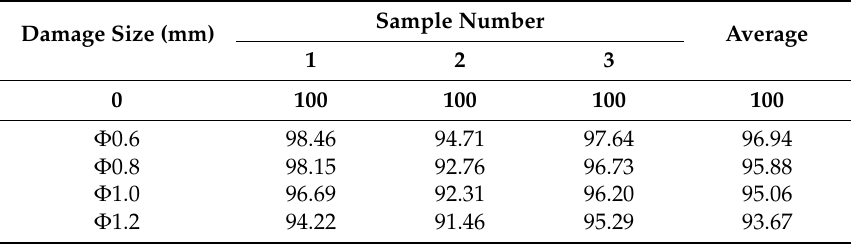
Table 2. Normalized ultrasound energy diffusion coefficient for damage category D1 (unit: %). Damage Size (mm)